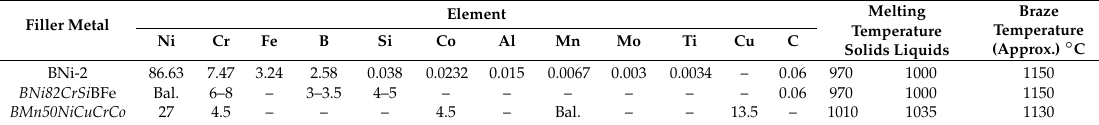
Table 1. Chemical composition of three types of brazing filler metals (in weight